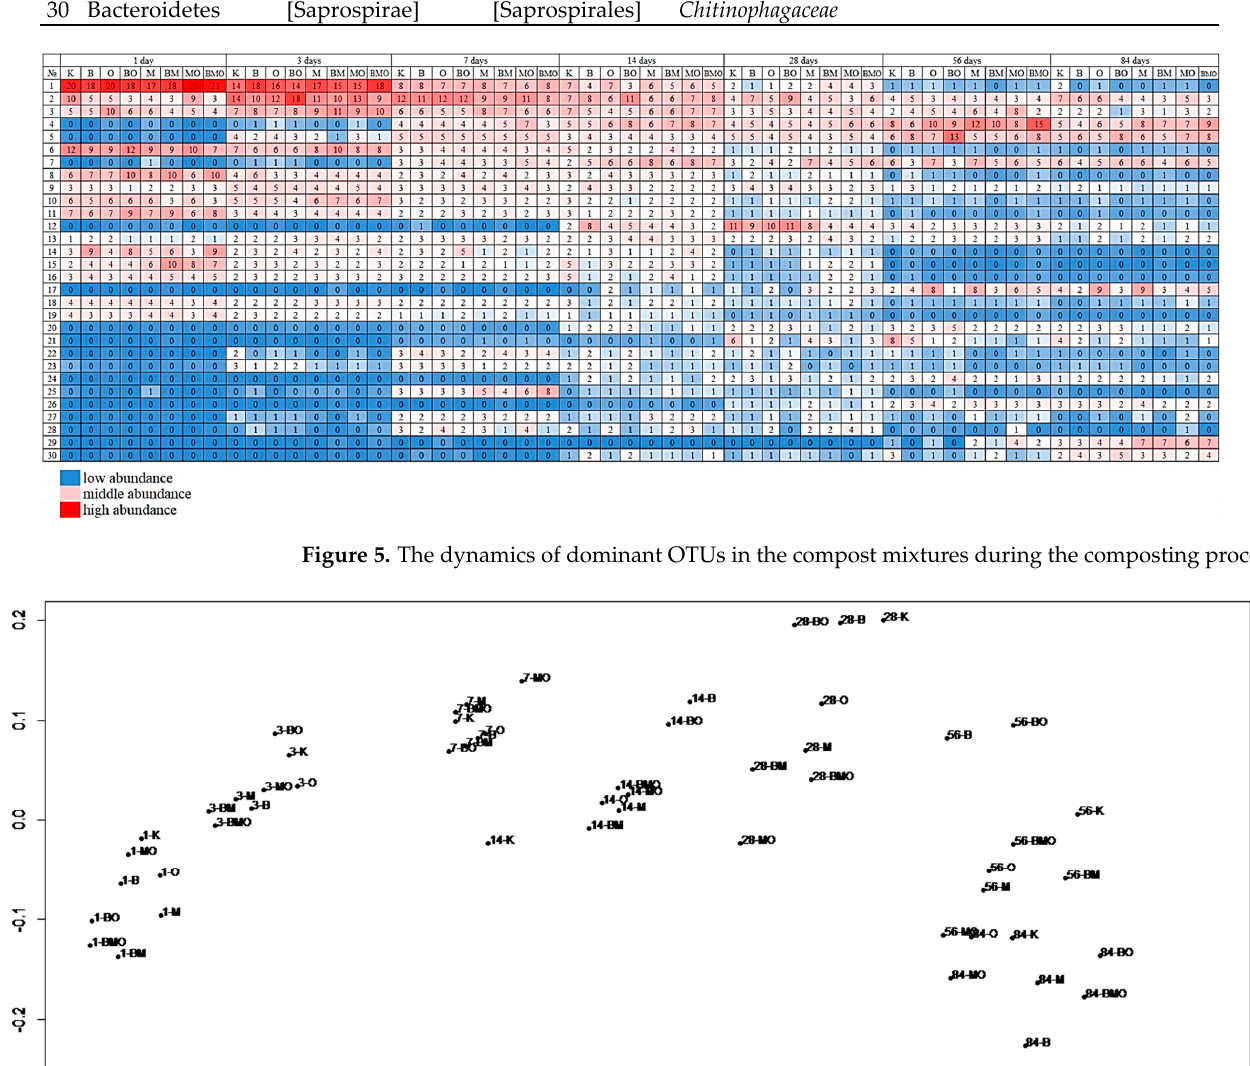
Figure 5. The dynamics of dominant OTUs in the compost mixtures during the composting process.